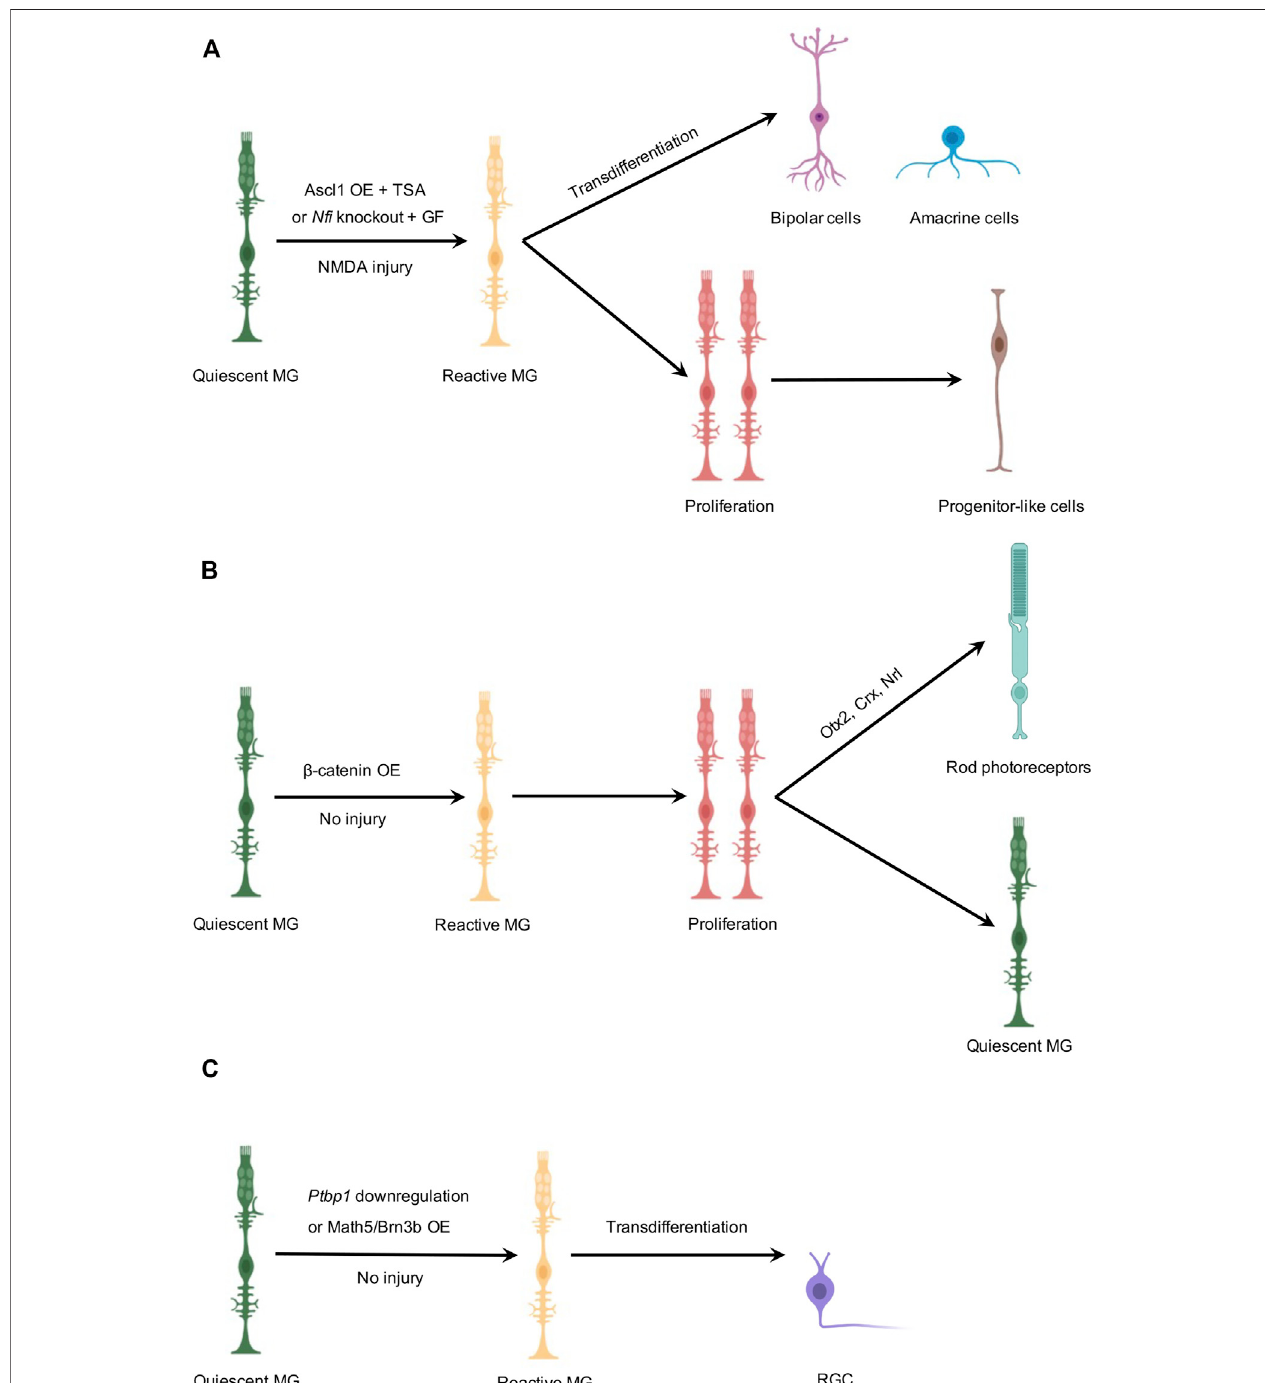
FIGURE1| SchematicillustrationofMG-derived invivo neurogenesisintheadultmouseretina. (A) MG-derivedregenerationofbipolaroramacrine-likecells.Inthe presenceofNMDA-inducedinjury,Ascl1overexpressioncombinedwithTSAor N fi deletioncombinedwithgrowthfactorsreprogramsMGintotwoclustersofcells.One cell cluster is composed of bipolar and amacrine-like cells, and the other cell cluster contains progenitor-like cells that are mostly non-neurogenic. (B) MG-derived regenerationofrodphotoreceptors.Intheabsenceofretinalinjury, β -cateninoverexpressionstimulatesMGtoreenterthecellcycletoproliferateasthe fi rststep.A subsequent gene transfer of Otx2/Crx/Nrl induces one daughter cell to differentiate into a rod photoreceptor, while the other daughter cell remains a quiescent MG. (C) MG-derived regeneration of RGCs. In the absence of retinal injury, Ptbp1 downregulation or Math5/Brn3b overexpression converts MG into RGCs by direct transdifferentiation. However, genetic-based fate mapping experiments, independent of AAV-mediated gene transfer, were not performed in these studies to trace the lineage of MG after Ptbp1 downregulation or Math5/Brn3b overexpression. OE, overexpression; GF, growth factors. Created with BioRender.com.